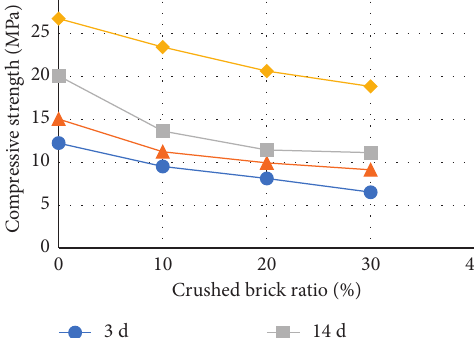
Figure 3: Effect of crushed brick ratio on splitting tensile strength of